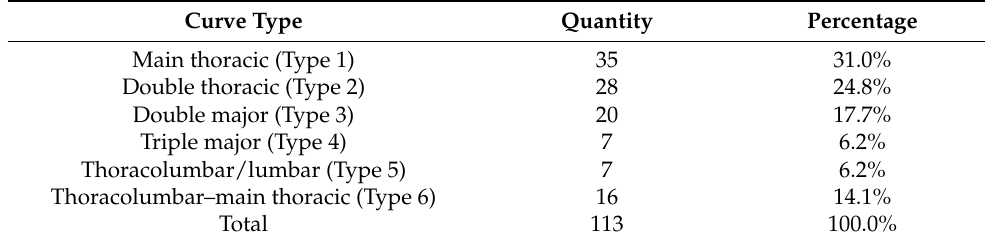
Table 2. Distribution of the different types of adolescent idiopathic scoliosis patients based on established Lenke classification [14].